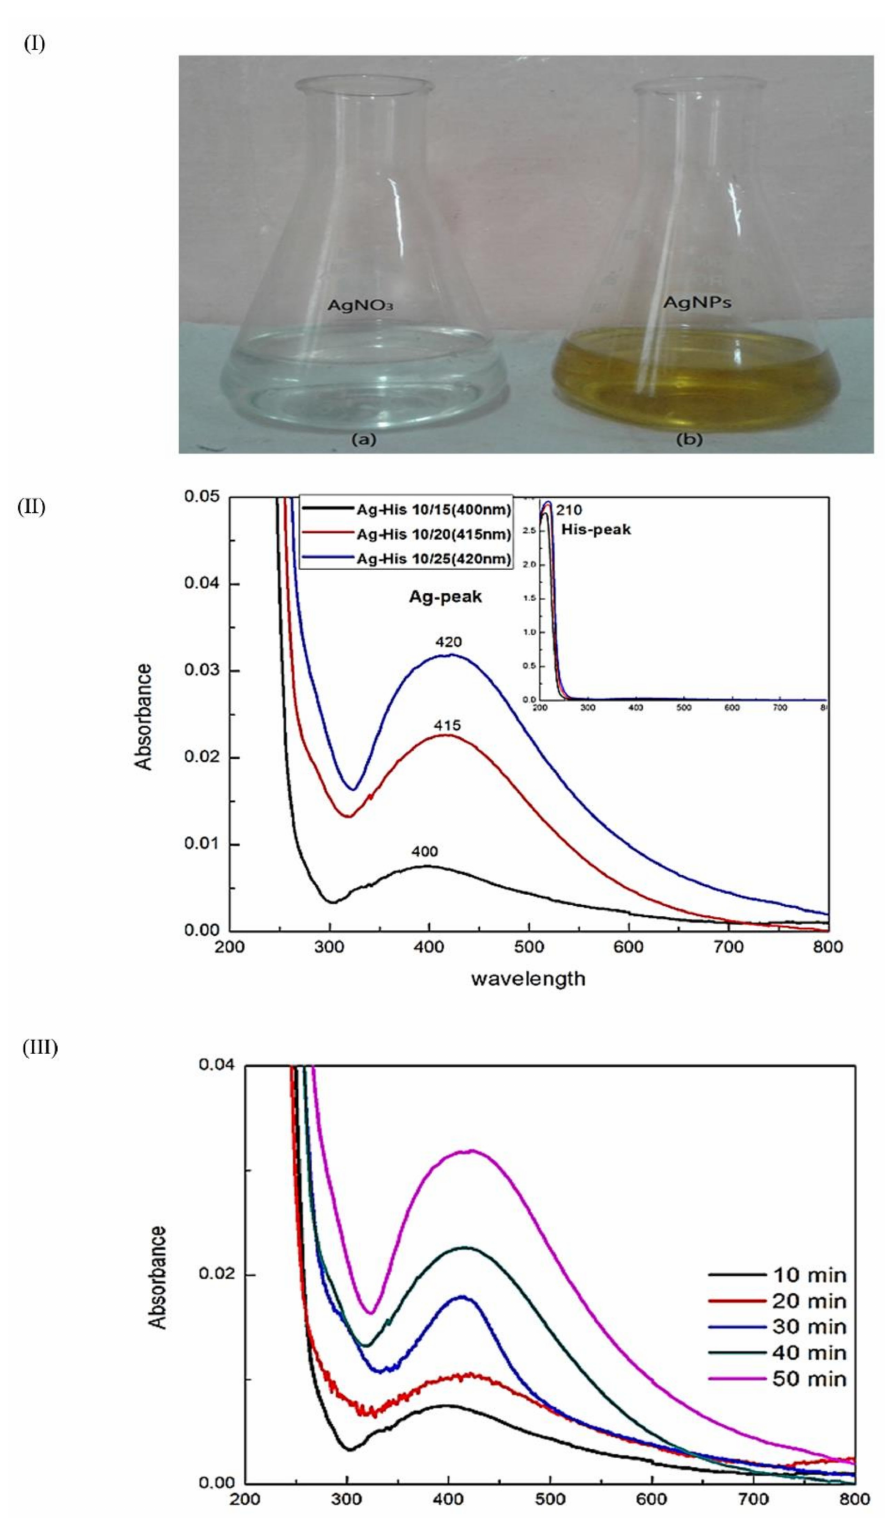
Figure 1. ( I ) Color transition illustrating the formation of AgNPs; ( II ) UV–Visible spectra of Ag- NPs synthesized using various molar ratios of AgNO 3 and L-histidine; ( III ) UV–Visible spectrum illustrating the optimization of time for the synthesis of